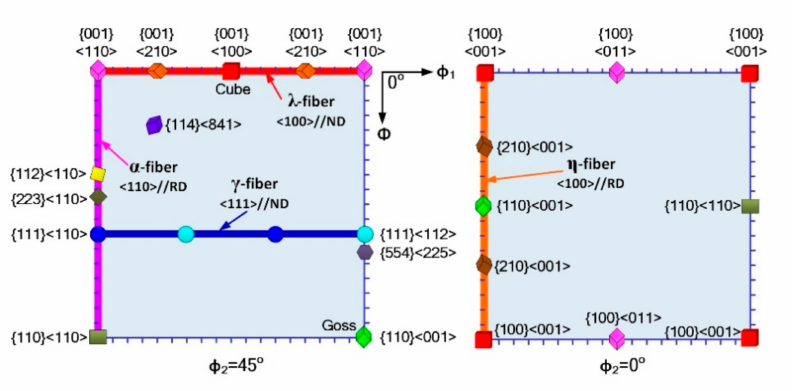
Figure 1. Typical texture components of non-oriented silicon steel in constant ϕ 2 = 0 ◦ and ϕ 2 = 45 ◦ ODF